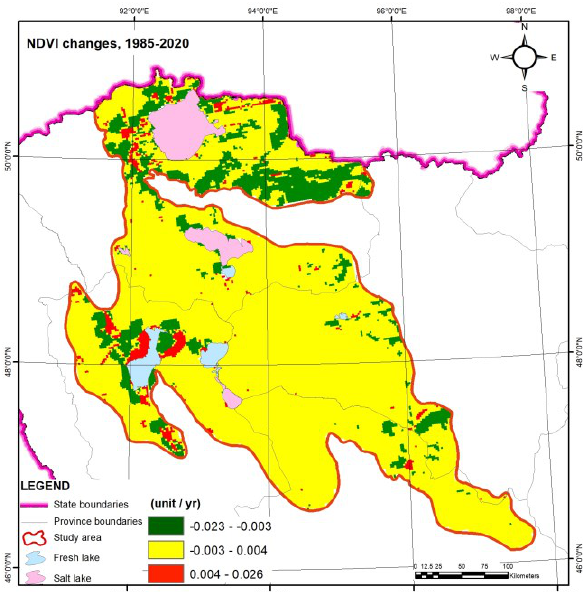
Figure 4. NDVI changes in the summers of 1985 to